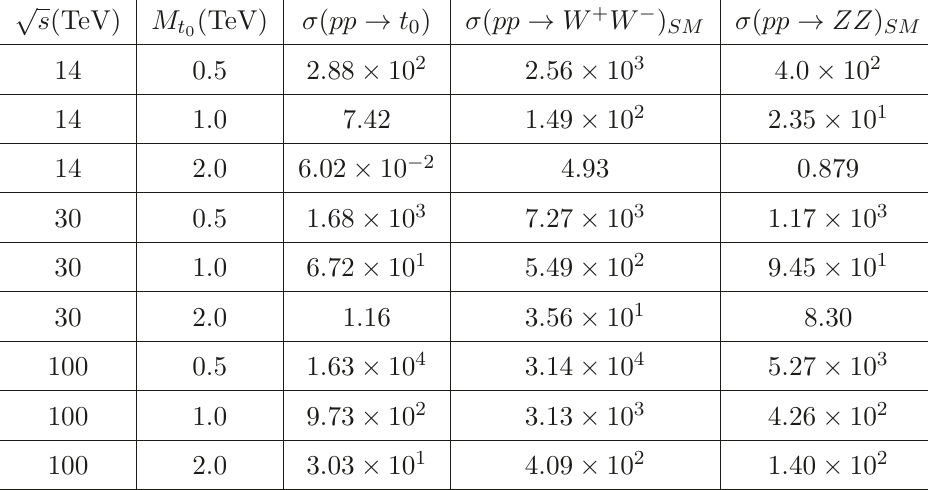
Table 6 . Gluon fusion neutral Triplet boson production cross sections(in fb ) at the LHC and beyond. Here we assume that